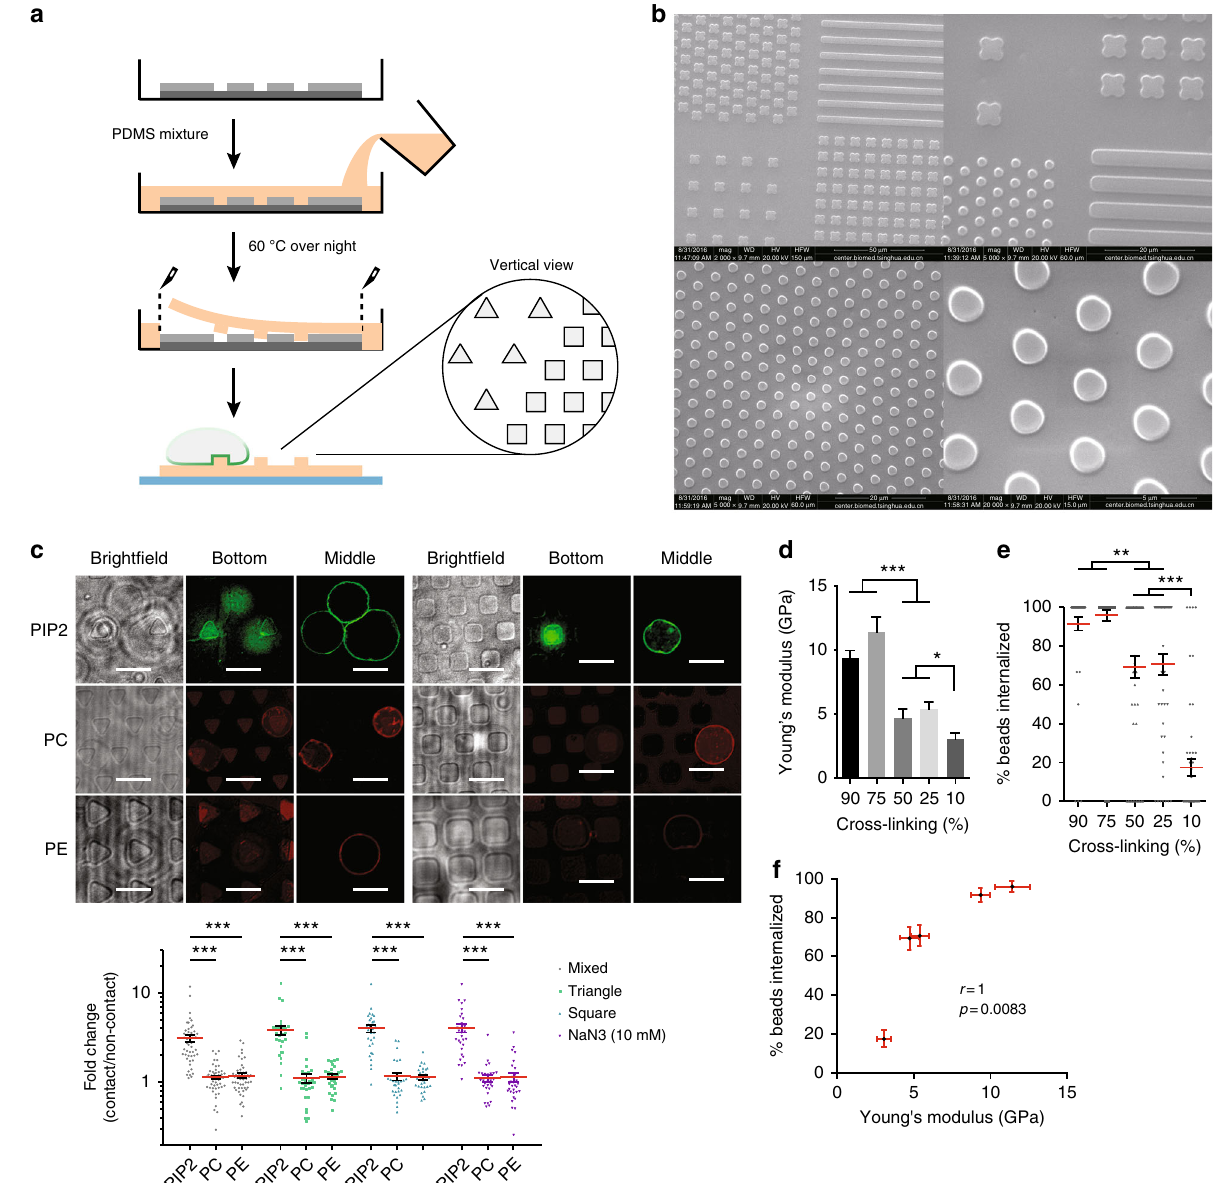
Fig. 4 Autonomous PIP2 sorting in response to physical structures. a Schematic of the procedure of making PMSD pattern. b SEM images of PDMS micropatterns. c Biotinylated-GPMVs were labeled with BODIPY FL-PIP2, TopFluor-TMR PC, or PE and incubated with PDMS triangular and rectangular patterns coated with NeutrAvidin. Images were taken when GPMV were settled onto a speci fi c pattern. Fold changes, de fi ned as the ratio of fl uorescence intensity of a given lipid at the pattern contacting regions over non-contacting regions, were measured for all shapes with or without 10 mM NaN 3 . n ≥ 30, N = 5. Scale bars, 5 µ m. *** p < 0.001 by one-way ANOVA with Scheffé post hoc. d Polystyrene beads with different degrees of crosslinking on glass surfaces were subjected to force-indentation displacement probing with a stiff probe. The values of stiffness (Young ’ s modulus) were obtained via indentation analysis with Veeco software. n ≥ 12, N = 3. *** p < 0.001 and * p < 0.05 by one-way ANOVA with Scheffé post hoc. e RAW264.7 cells were incubated with 2 µ m, biotin-BSA-labeled polystyrene beads with varied degrees of crosslinking for 90 min at 37 °C. The ef fi ciency of phagocytosis was analyzed as per phagocytosis assay. n = 50, N = 4. *** p < 0.001 and ** p < 0.01 by one-way ANOVA with Scheffé post hoc. f Correlation analysis of stiffness as shown in d and phagocytosis ef fi ciency as shown in e by non-parametric method. Spearman ’ s rank correlation coef fi cient r = 1. p =